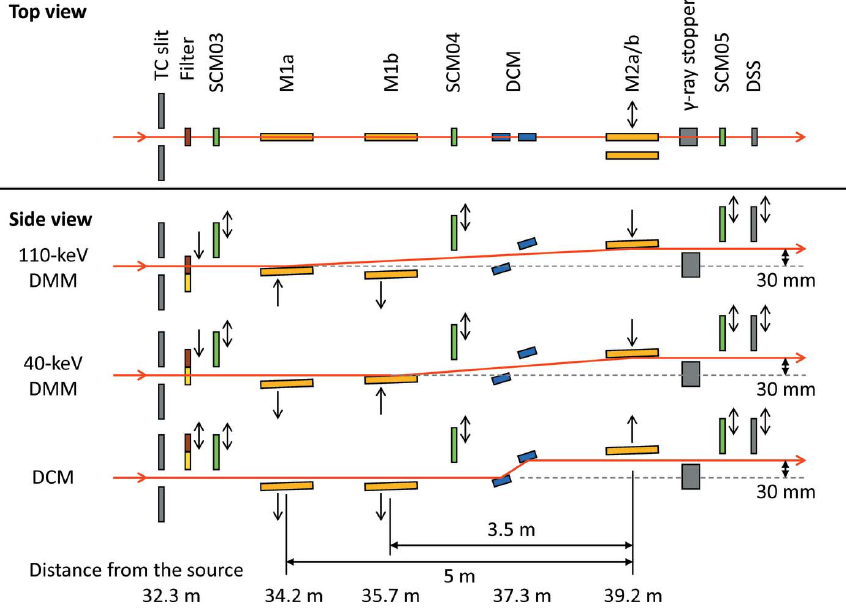
Figure 2 Schematics of the optical configurations for the 110 keV DMM (M1a–M2a), 40 keV DMM (M1b– M2b) and DCM modes. TC slit: transport channel slit; SCM: screen monitor; DCM: double-crystal monochromator; DSS: downstream shutter.